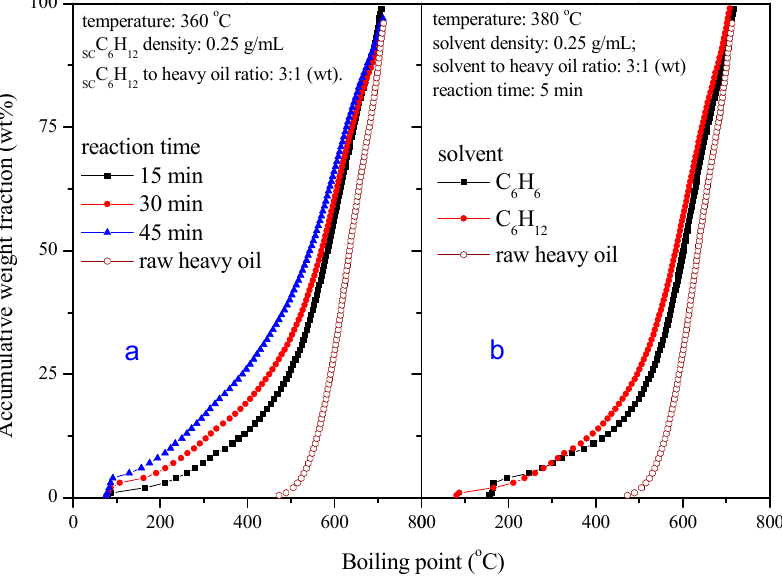
Figure 3. Boiling-point distribution of visbreaking products. ( a ) Visbreaking in SC C 6 H 12 at extended reaction time and ( b ) visbreaking in different SCF solvents. Table 2. Properties of visbreaking products obtained in SC C 6 H 12 . Temperature of 360 ◦ C, SC C 6 H 12 - to-heavy-oil ratio of 3:1 (wt), and SC C 6 H 12 density of 0.25